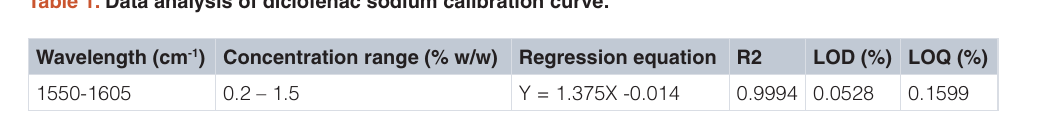
Table 1. Data analysis of diclofenac sodium calibration